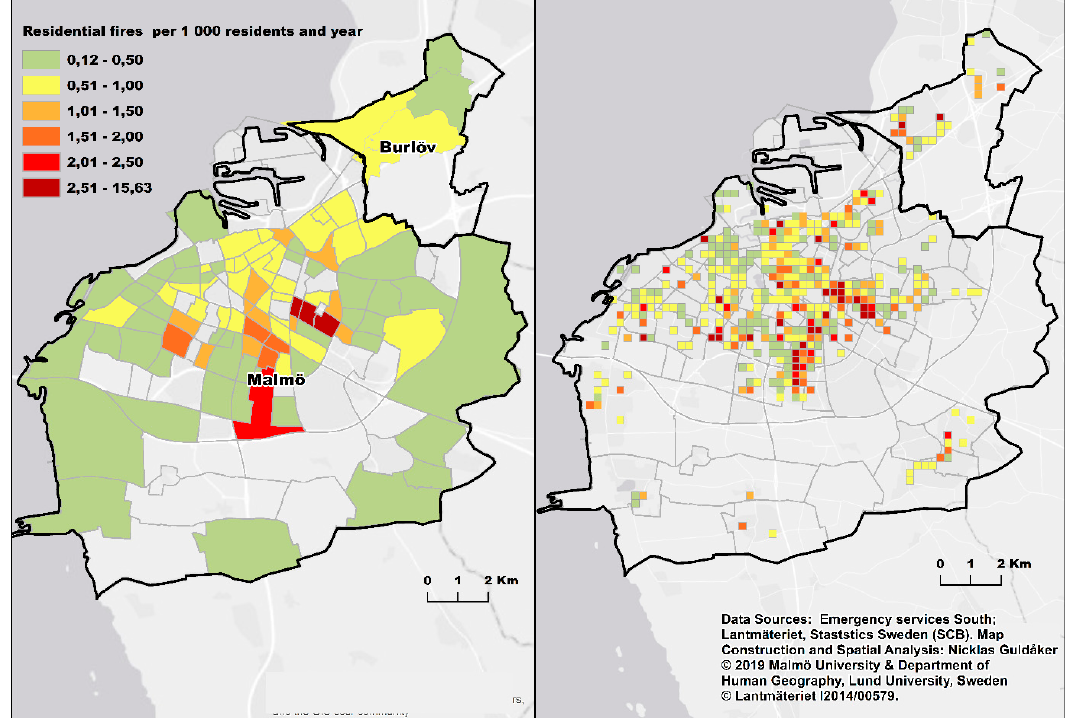
Figure 5. Choropleth maps as subareas ( left ) and grids ( right ) of the municipalities of Malmö and Burlöv, Sweden. The residential fire data period was 2007–2015.